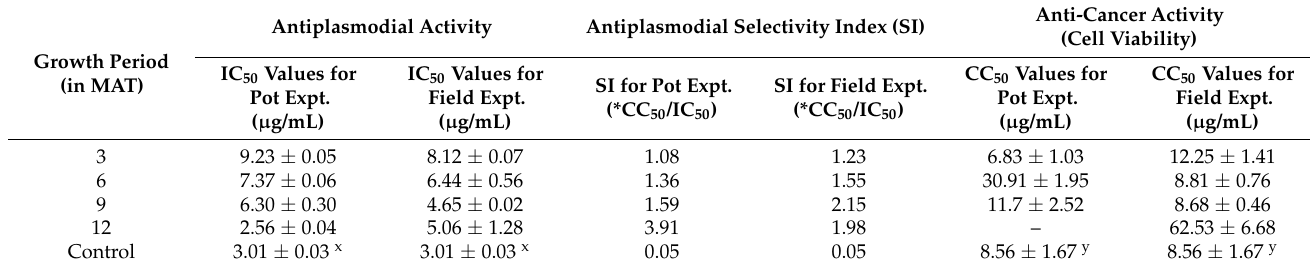
Table 8. The effects of plant growth period on the antiplasmodial and anti-cancer activity of C. sanguinolenta